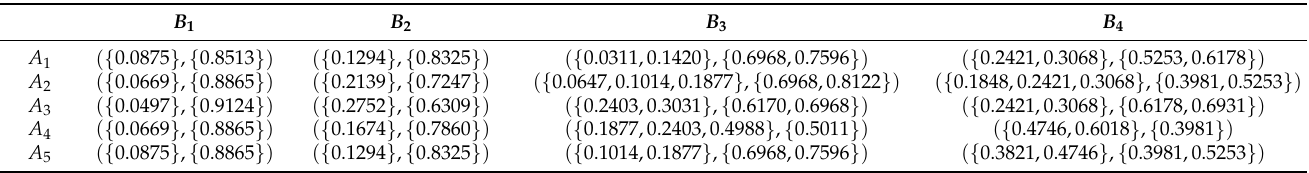
Table 3. Weighted decision set for Sophie.